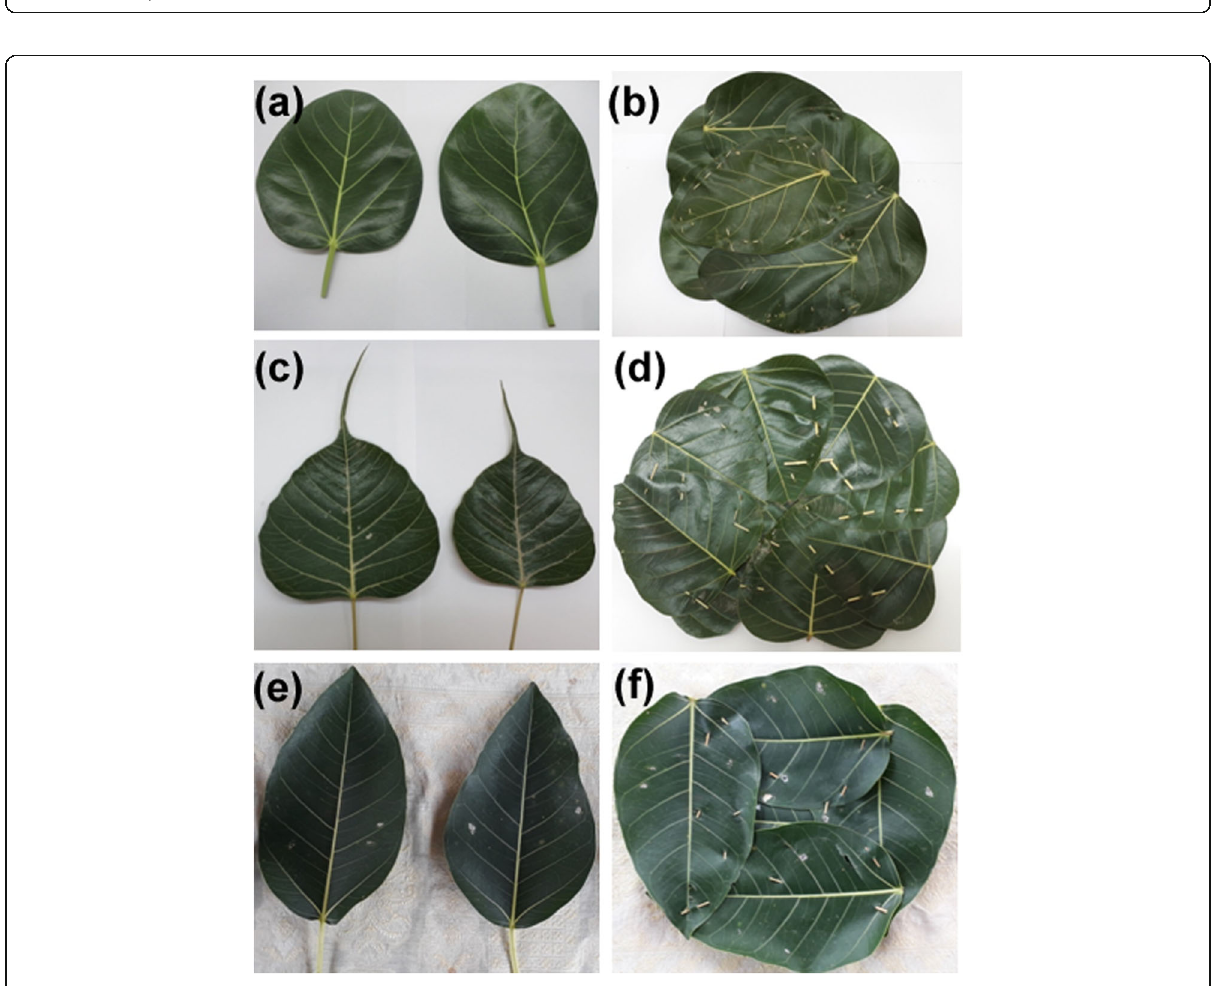
Fig. 6 a The leaves of banyan, F. bengalensis , ( b ) the hand stitched dining plate made from the leaves of banyan, ( c ) the leaves of aswatha , F. religiosa , ( d ) the hand stitched dining plate made from the leaves of aswatha , ( e ) the leaves of juvvi , F. virens and ( f ) the hand stitched dining plate made from the leaves of